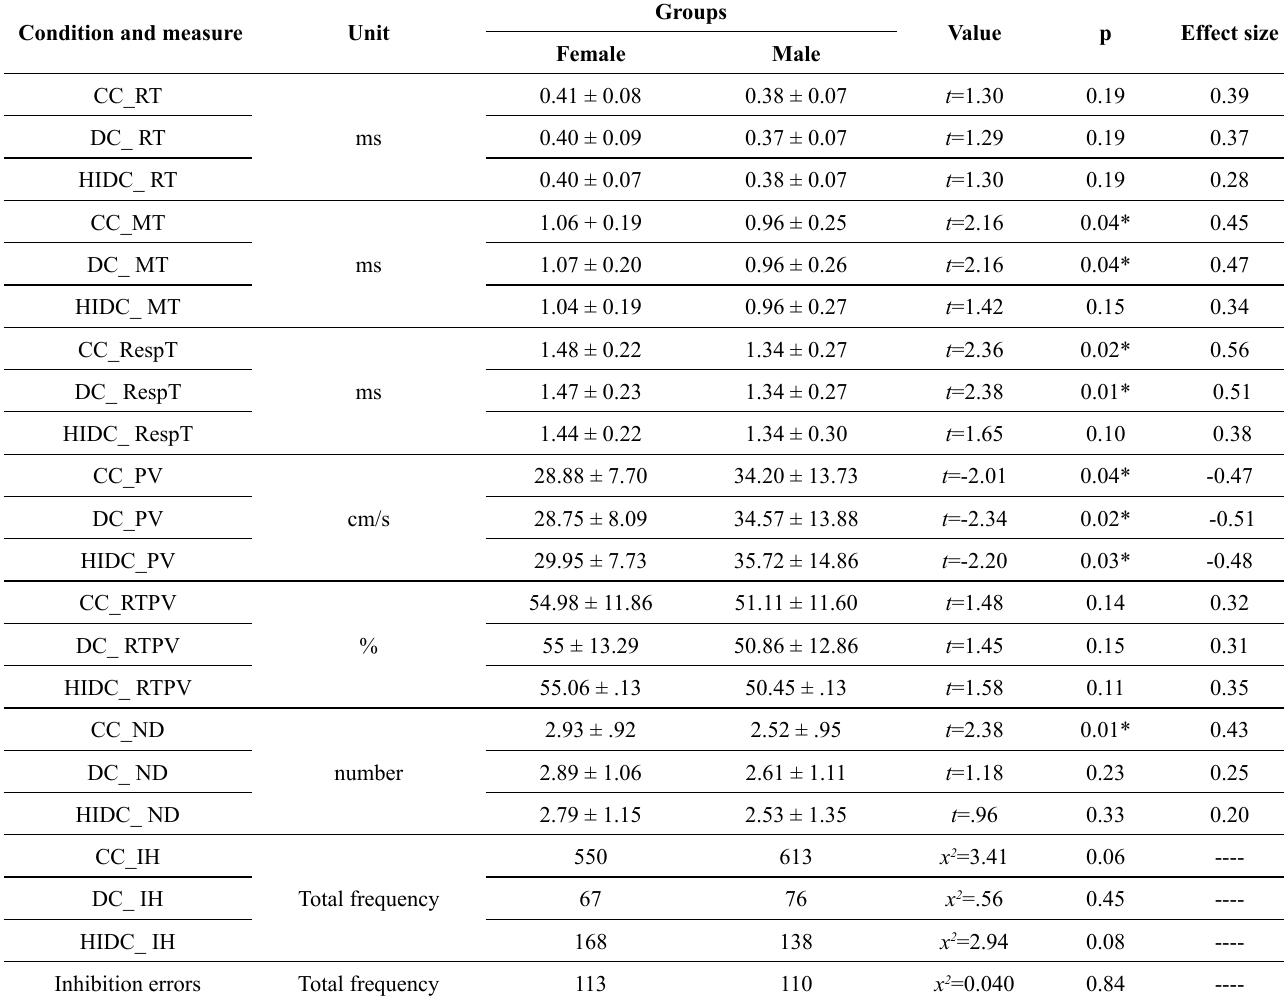
Table 1. Means and standard deviations of women and men for dependent measures obtained in all conditions of execution; results of Student’s t-tests and Chi-squared tests; effect size